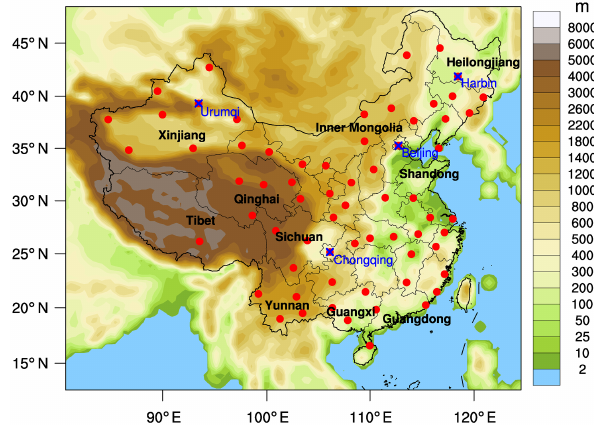
Figure 2. Topography of China and locations of 66 stations ana- lyzed in this study. Cross marks indicate the four representative sta- tions: Harbin, Urumqi, Beijing, and Chongqing.